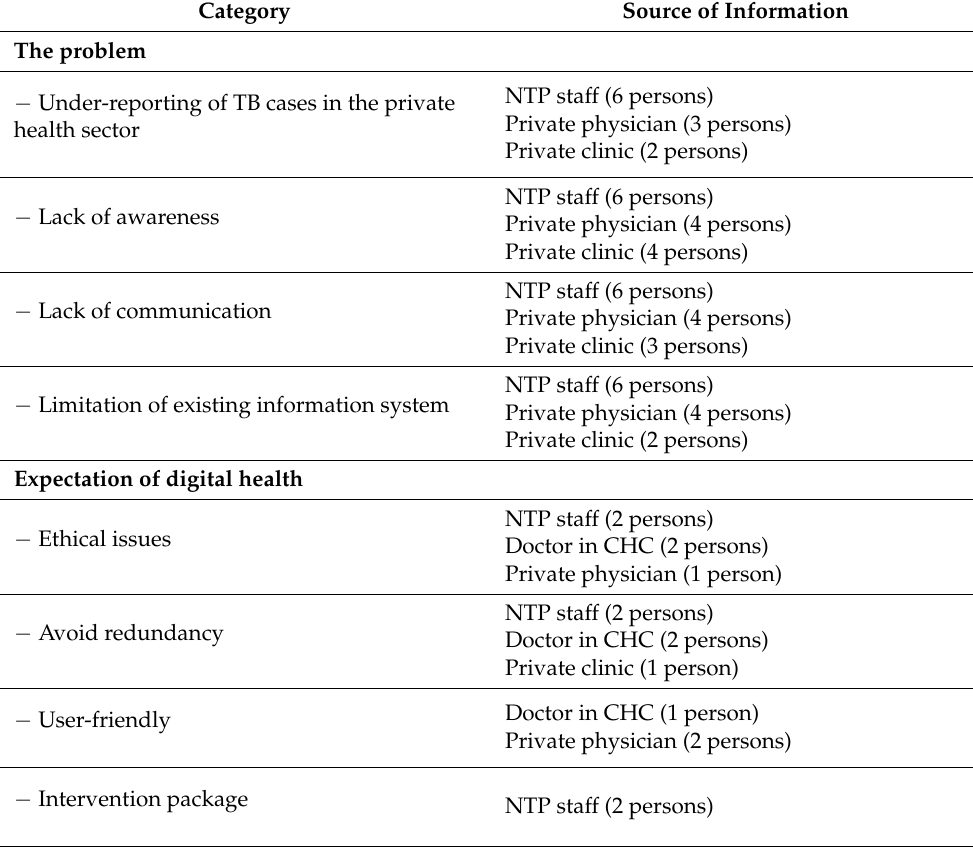
Table 2. Issues related to DPPM TB problems and expectations of digital